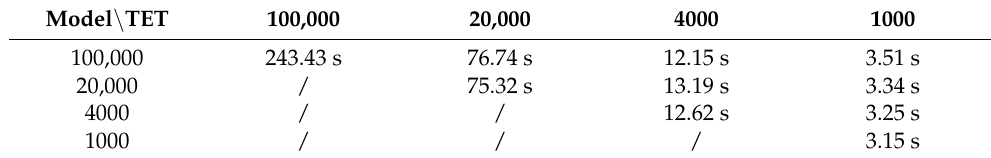
Table 1. Computational time (CPU) of position-based simulation for a dog model with different faces. Model \ TET